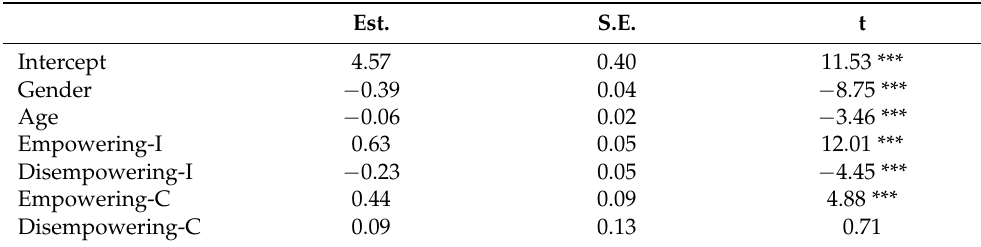
Table 3. Estimates of Fixed Effects from Multilevel Regression Analysis with Satisfaction as Dependent Variable.